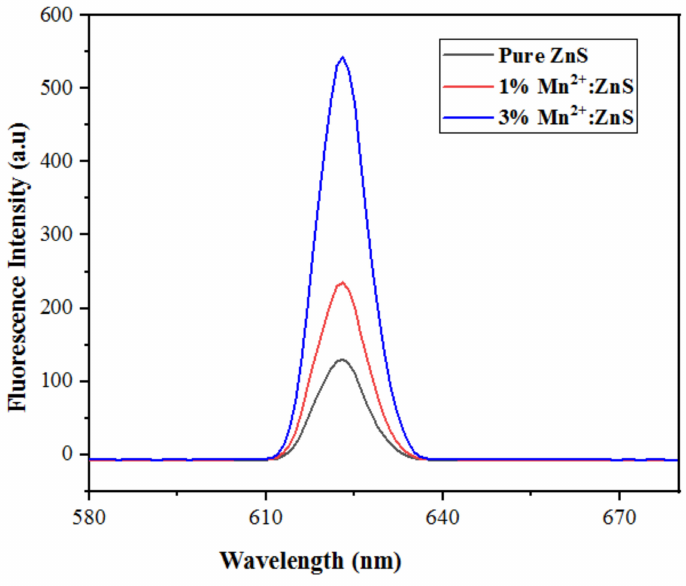
Figure 7. Fluorescence spectra of Mn 2+ :ZnS QDs with various percentages of Mn 2+ ions ( λ ex = 320 nm).